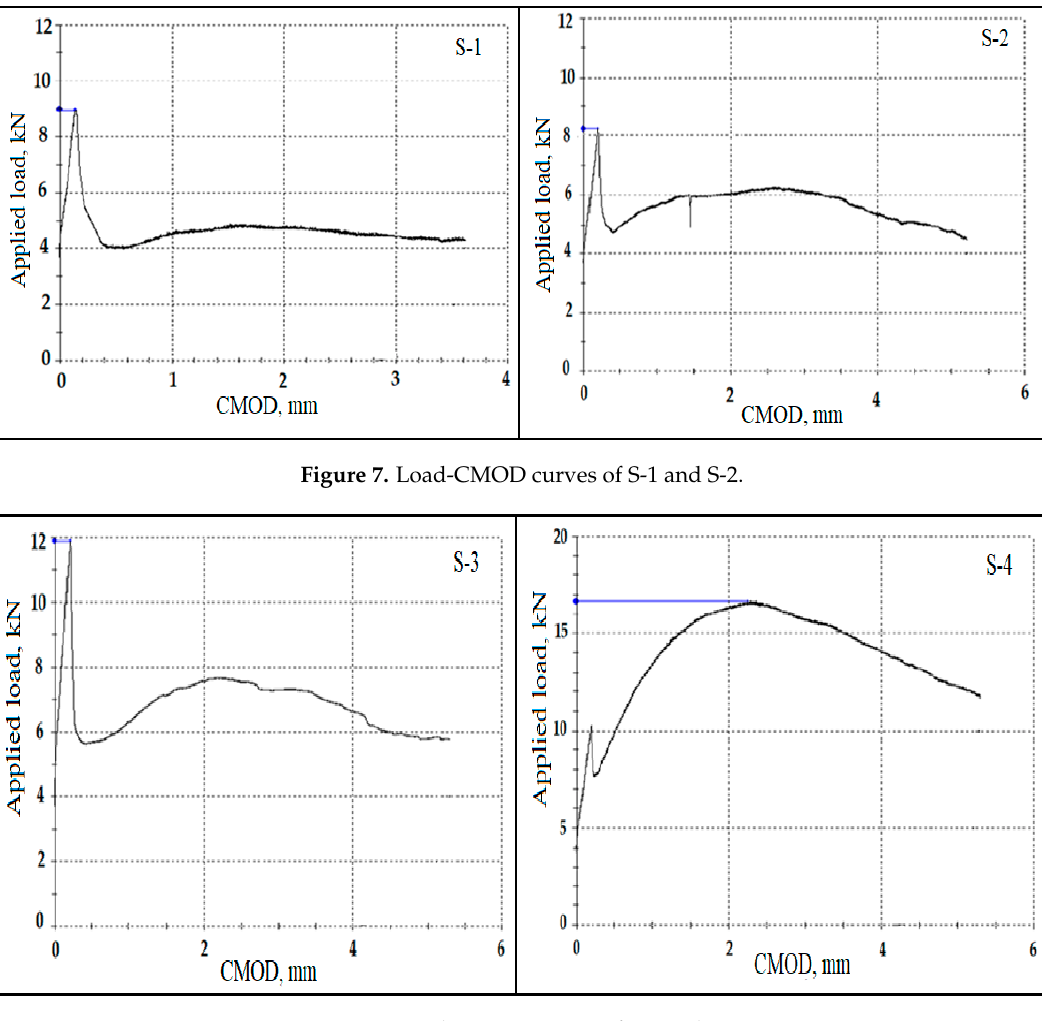
Figure 8. Load ‐ CMOD curves of S ‐ 3 and S ‐ 4.